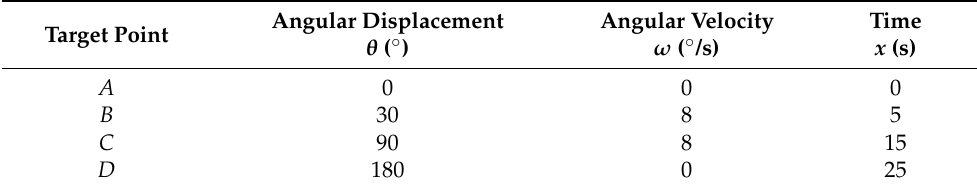
Figure 11. Point-to-point joint motion planning with constrained velocity: ( a ) Initial knots; ( b ) Newly-built knots. Table 1. Constraint requirements for target points of joint